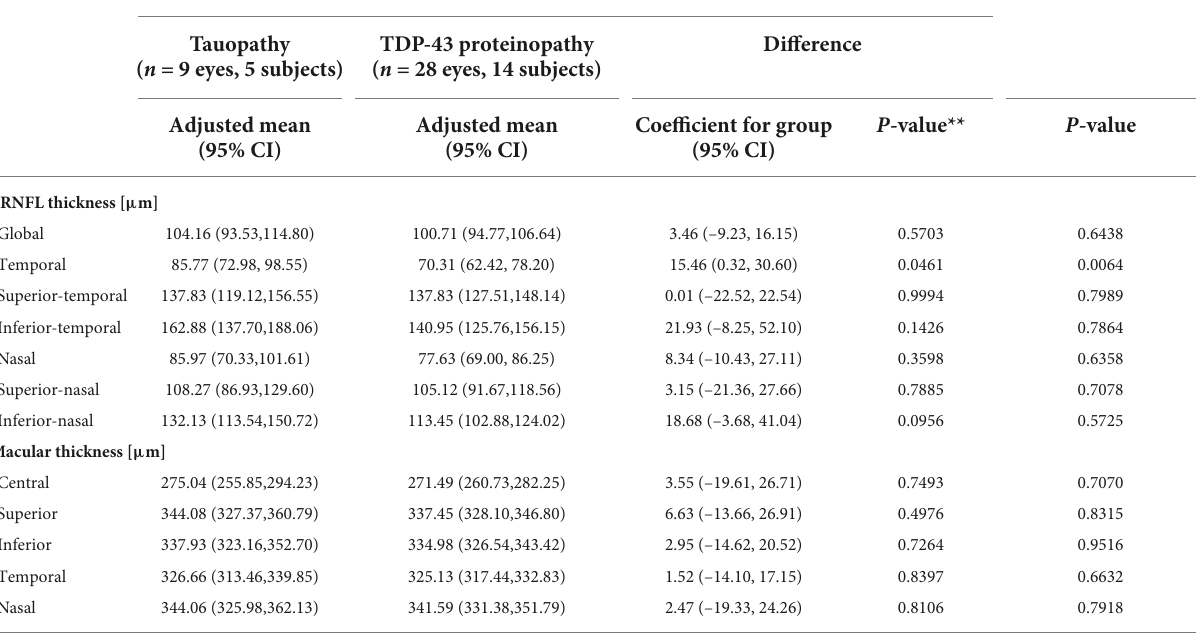
TABLE 2 Mean peripapillary retinal nerve fibre layer and macular thickness values in tauopathy and TDP-43 proteinopathy groups, adjusted for age and